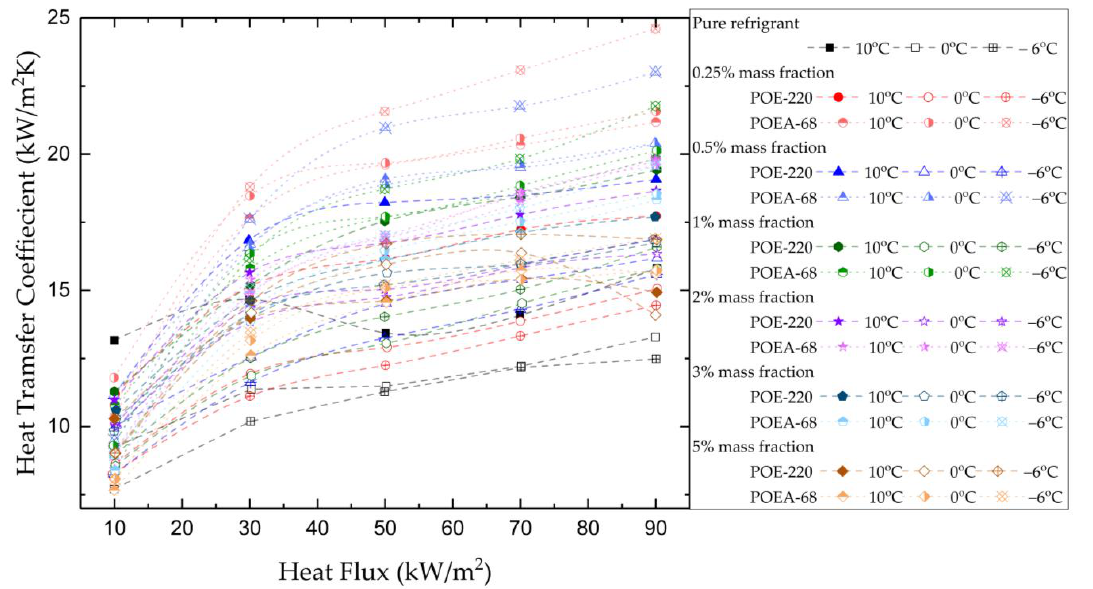
Figure 4. HTC versus heat flux for pure, R-1234ze(E)/POEA-220 and R-1234ze(E)/POEA-68 oil at 10, 0 and −6 °C [19].